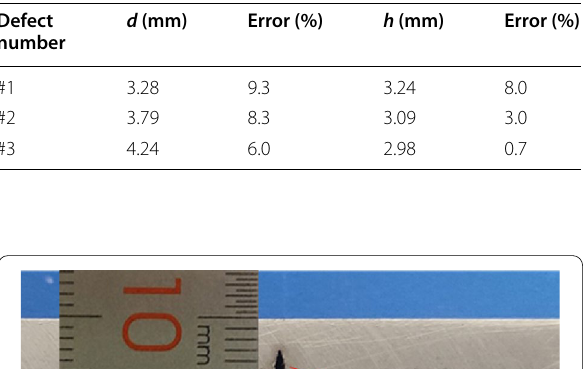
Table 1 Calculated crack depths and heights and relative errors by Sparse-SAFT